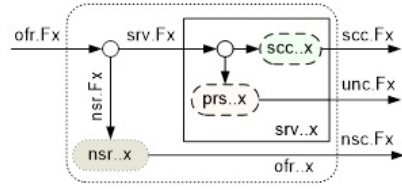
Figure 3. Causal and intuitionistic fuzzy traffic